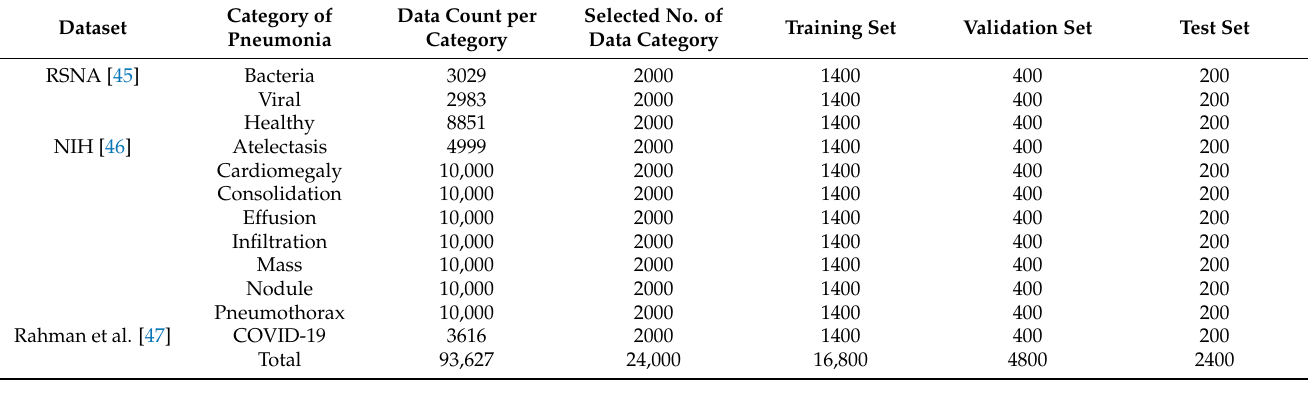
Table 1. Description of the chest X-ray (CXR) dataset showing different categories of pneumonia illnesses and the distribution of images per category as well as the number of selected images per category.